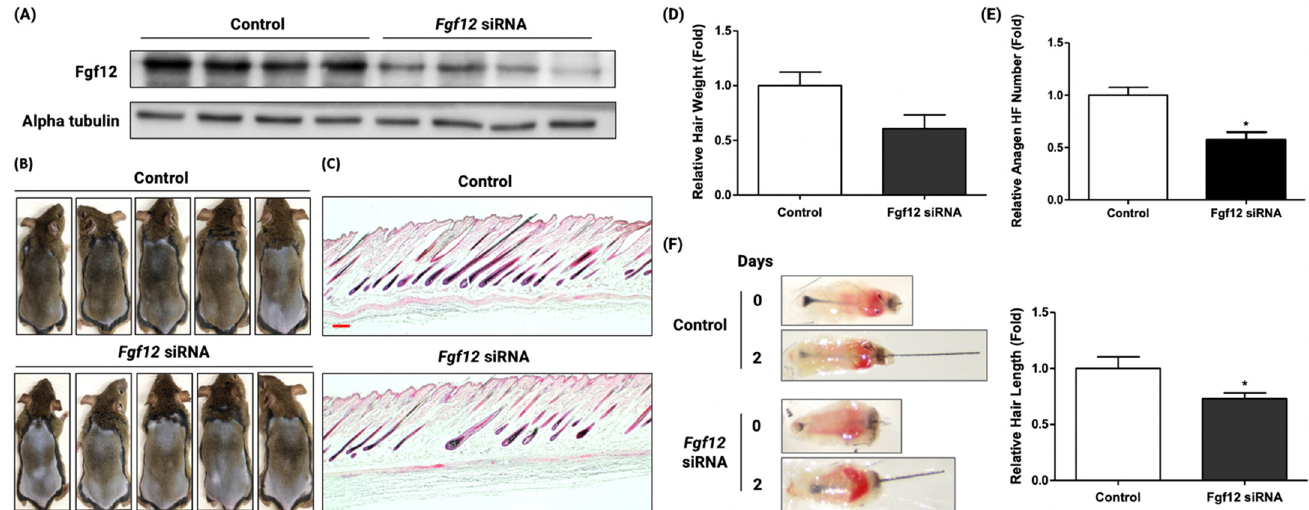
Figure 2. Fgf12 knockdown delayed anagen entry of mouse hair follicles. ( A ) Western blotting confirmed the siRNA-mediated knockdown of Fgf12 in mouse dorsal skins. ( B ) When compared to negative controls, telogen-anagen transition in C3H/HeN mouse was delayed by Fgf12 siRNA injection into the mouse dorsal skin; n = 5. ( C ) Hematoxylin and eosin (H&E) staining of the mouse dorsal skin in each group is shown. scale bar = 100 μ m. ( D ) The hair weight of each group was measured; n = 5. ( E ) Quantification of anagen follicle number in H&E-stained images indicates that Fgf12 siRNA delays anagen entry of hair follicles. ( F ) Mouse vibrissae follicles were isolated and incubated with Fgf12 siRNA. Fgf12 knockdown exhibited decreased hair fiber length compared to the control group; n = 10–15, ×1.5 magnification. All data were expressed as mean ± standard error (* p < 0.05 versus the control group).